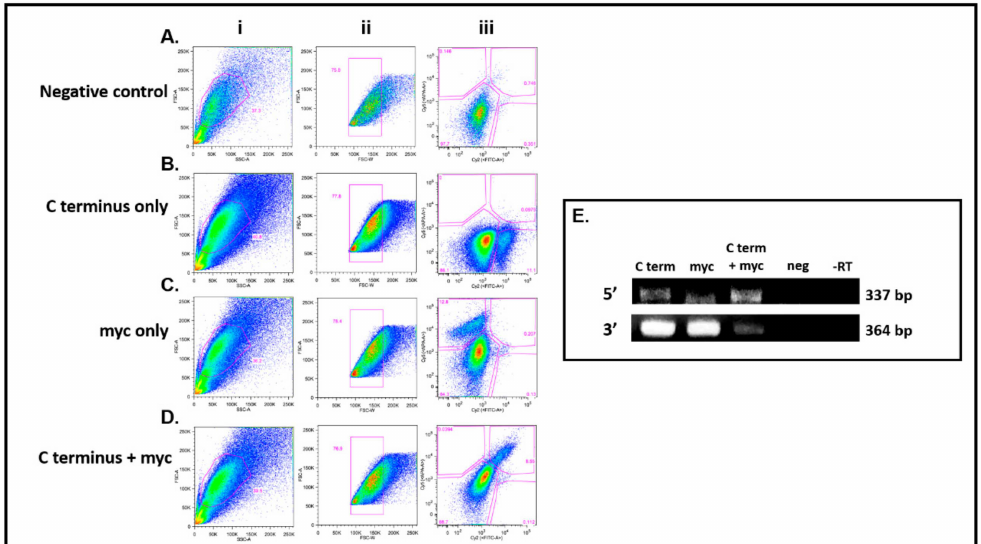
Figure 5. DDX4-positive transfected HEK 293T cells isolated by FACS. Staining of pFLAG-DDX4-myc transfected cells to demonstrate isolation of DDX4 cells using antibodies against the C-terminus of DDX4 or the myc tag. Column (i), intact cell gating (38.5% ± 1%), (ii) intact cells gated to exclude cell aggregates (77.2 ± 0.6%). ( A )(iii) negative control for non-specific binding of secondary Cy2 and Cy5 antibodies, 97.7% unstained cells. ( B )(iii) 11.1% positive staining with primary C-terminus and Cy2 secondary antibody. ( C )(iii) 12.8% positive staining with myc primary and secondary Cy5 antibody. ( D )(iii ) 8.55% dual stained using C-terminus and myc antibodies. ( B iii– D iii) Percentage of unstained cells comparable to negative control (86.1, 84.3 and 88.7, respectively). ( E ) 5 (cid:48) and 3 (cid:48) DDX4